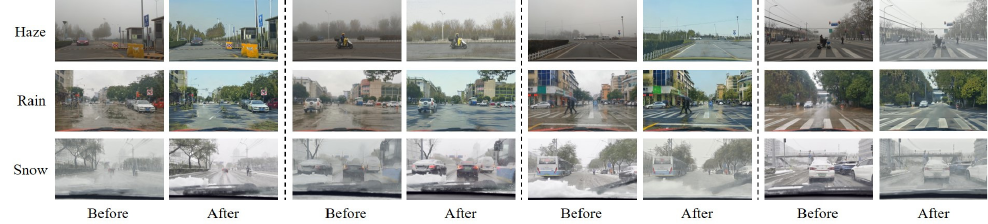
Figure 6. Weather removal results for the RDSBW dataset, showing examples of MWTG’s translation of adverse weather images into clear weather images; while MWTG was unable to recover objects and buildings hidden behind dense haze, it did not randomly insert fake